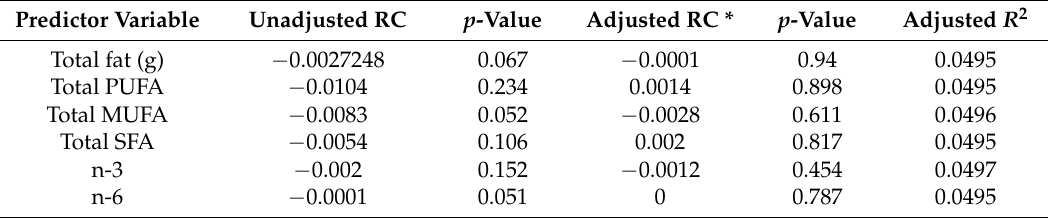
Table 3. Unadjusted and adjusted linear regression between dietary intake of fatty acids and MMSE score in the HCS cohort.